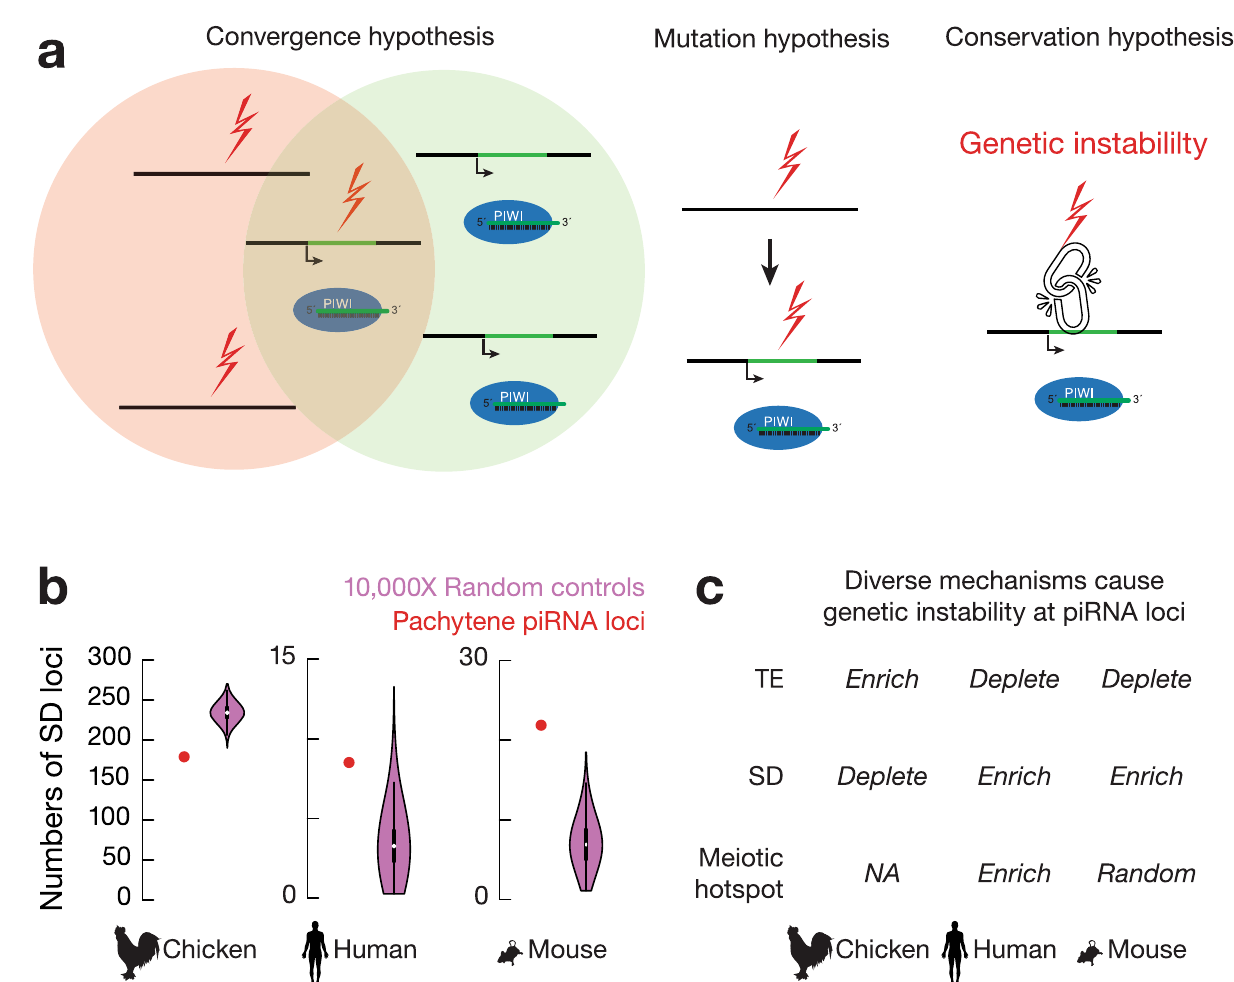
Fig. 4 | Convergent evolution drives the association between SV hotspots and pachytenepiRNAloci.a Threemodelsexplaintheassociationbetweenpachytene piRNAlociandSVhotspots. b NumberofpachytenepiRNAloci(red)andrandomly shuf fl ed control sequences (magenta) overlapping with SDs from chickens